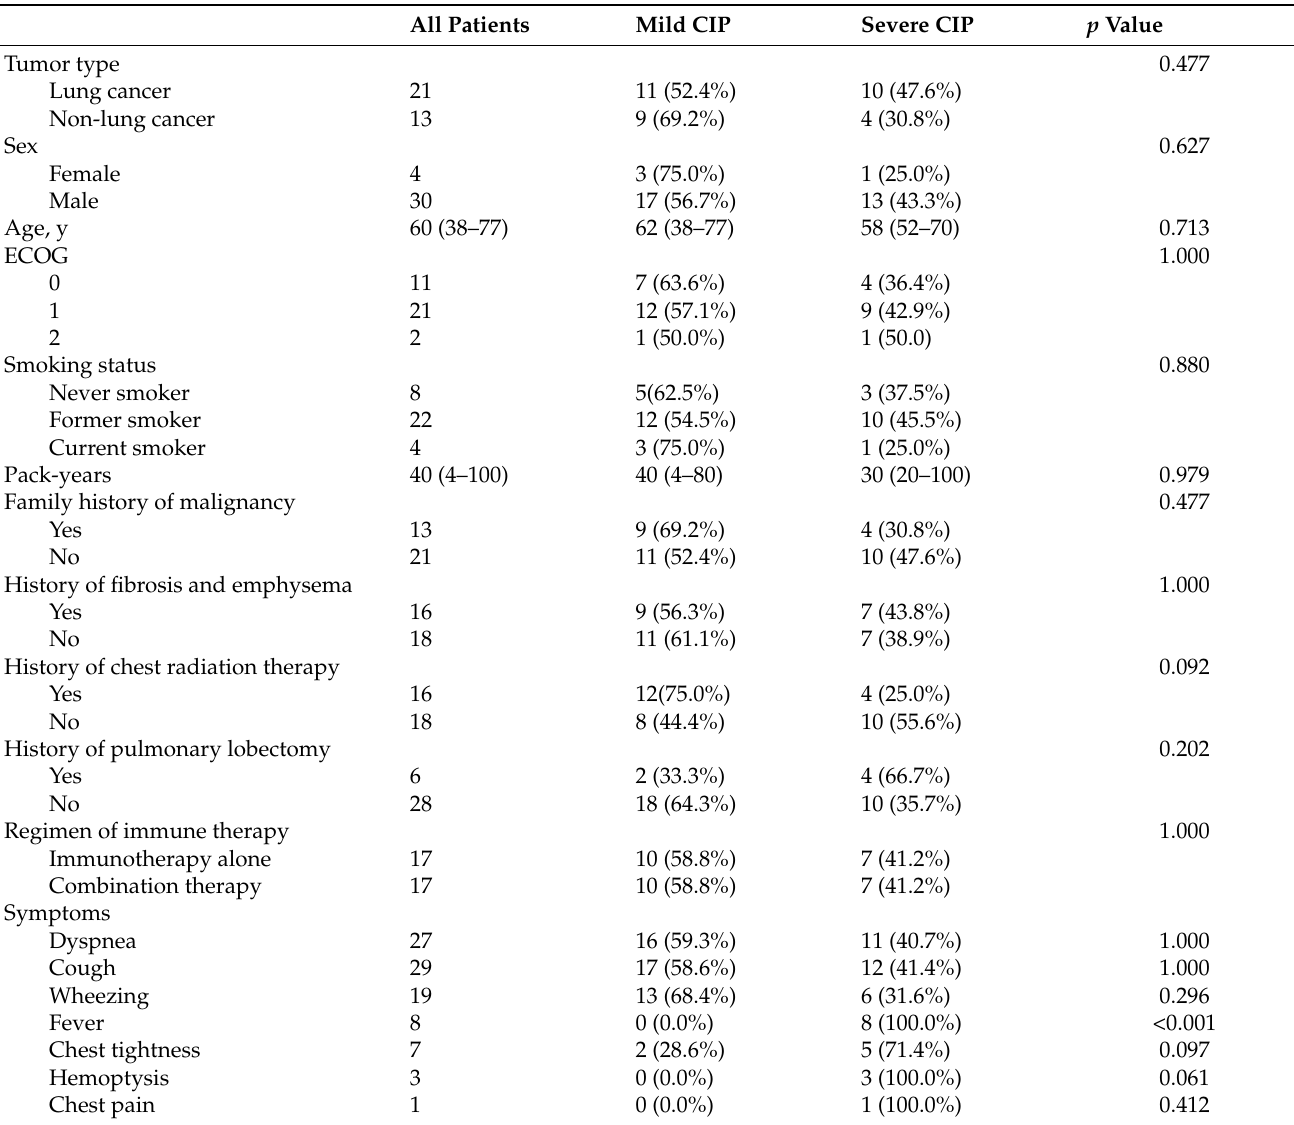
Table 1. Patient characteristics by